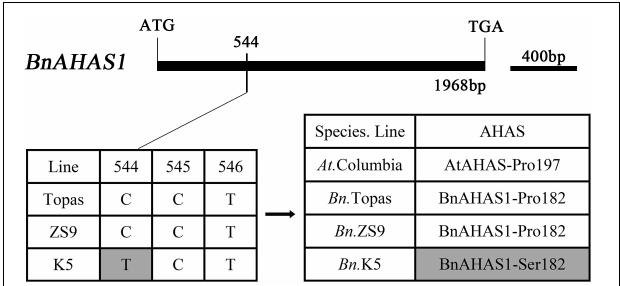
FIGURE 1 | Comparisons of DNA and protein of BnAHAS1 from Topas , ZS9 and K5 in Brassica napus L. The sequence of BnAHAS1 of Topas is from NCBI (GenBank ID: Z11524.1). AtAHAS was regarded as the reference protein.